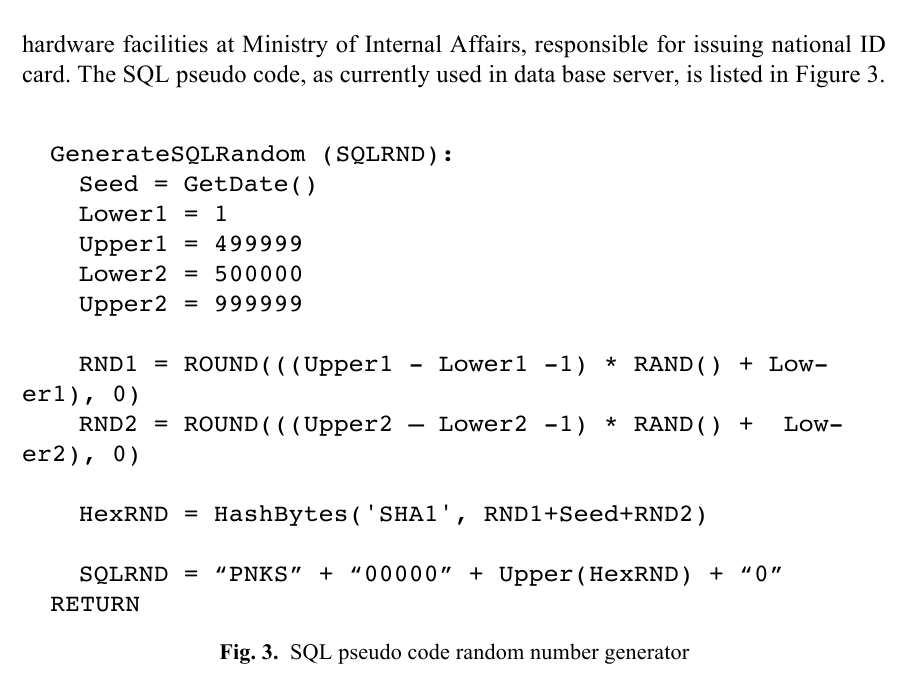
Fig. 3. SQL pseudo code random number